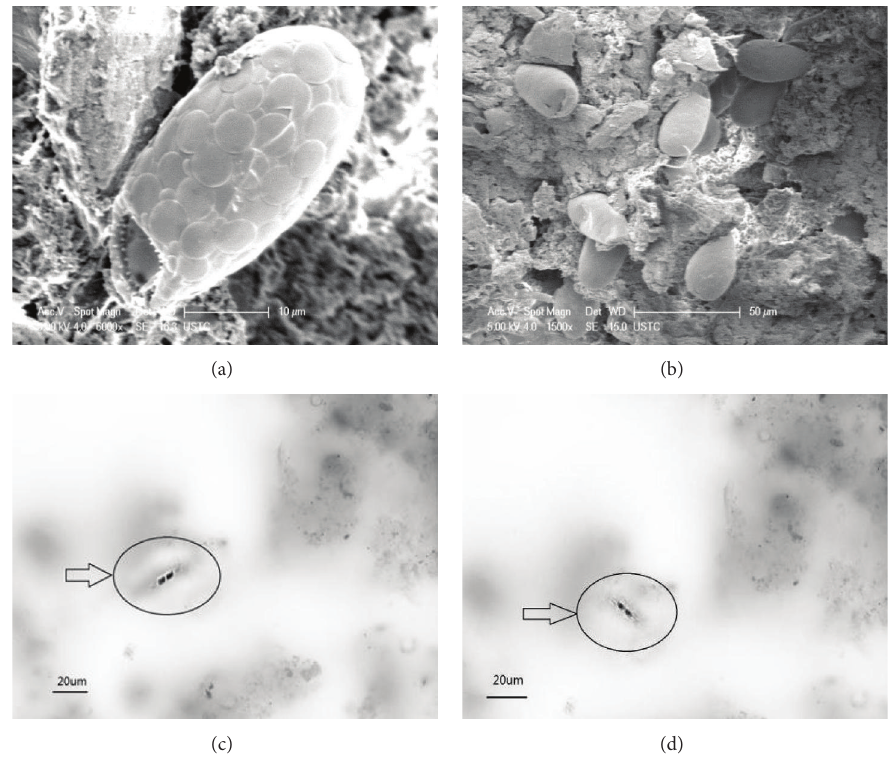
Figure 3: SEM images (a, b) and microscope photo (c, d) of IPC ceramsite after microbial inoculation.